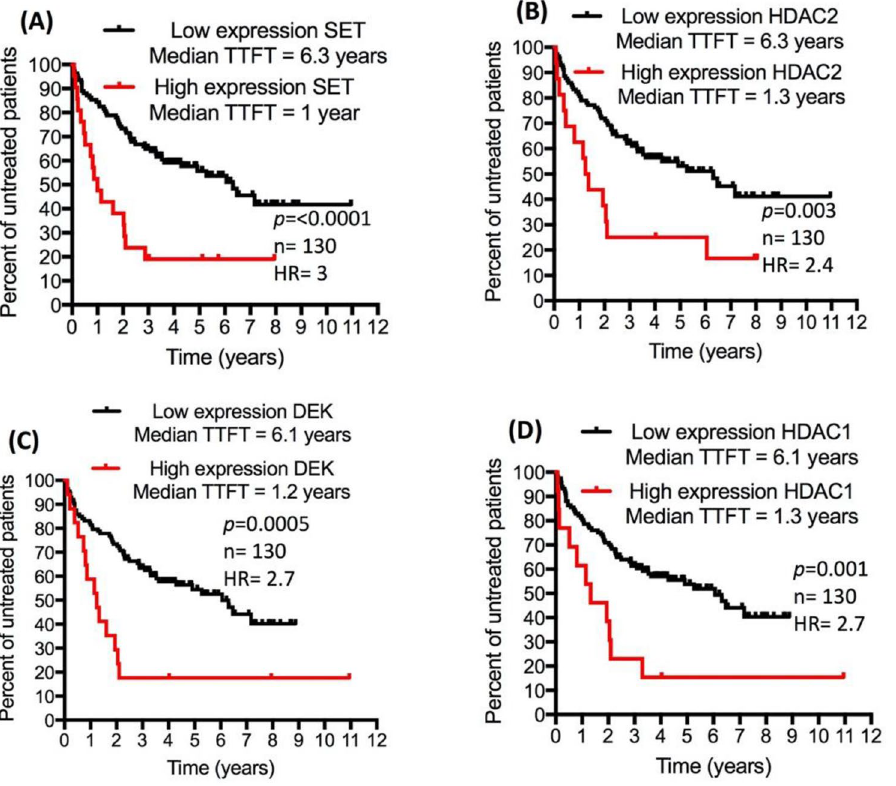
Figure 5. Increased gene expression of CK2α interaction partners is associated with short TTFT. CLL transcriptomics data set GSE39671 was used to investigate if the transcript expression of CK2α phosphorylation targets is associated with early need for therapy (which is a reflection of a progressive and poor prognosis CLL). High gene expression of SET ( A ), HDAC2 ( B ), DEK ( C ) and HDAC1 ( D ) was associated with short TTFT. HR, hazard ration of high-expression versus low-expression; TTFT, time-to-first-treatment.